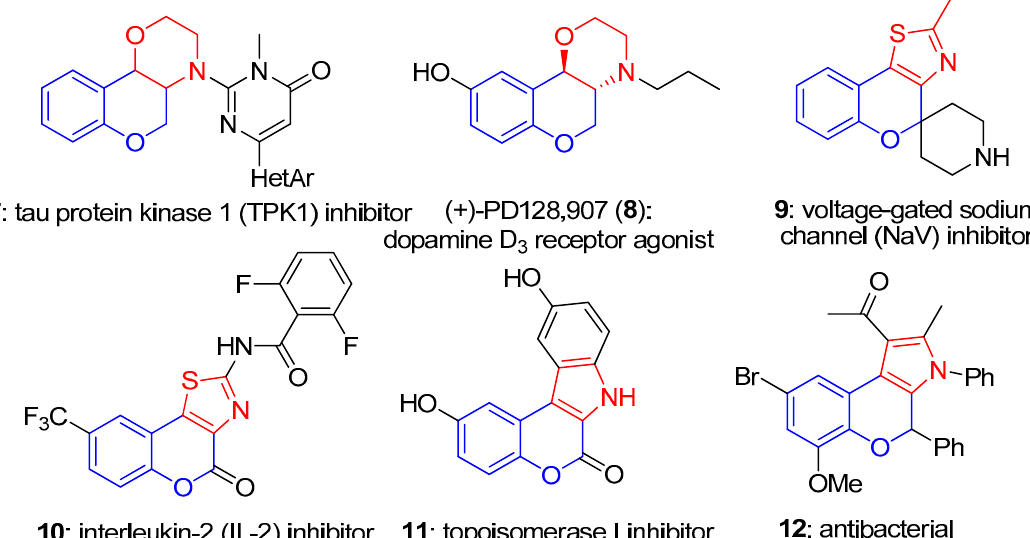
Figure 1. Structures of bioactive chroman, 2 H -chromene and coumarine derivatives condensed with morpholine, thioazole, and pyrrole units at the C-3 − C-4 bond.